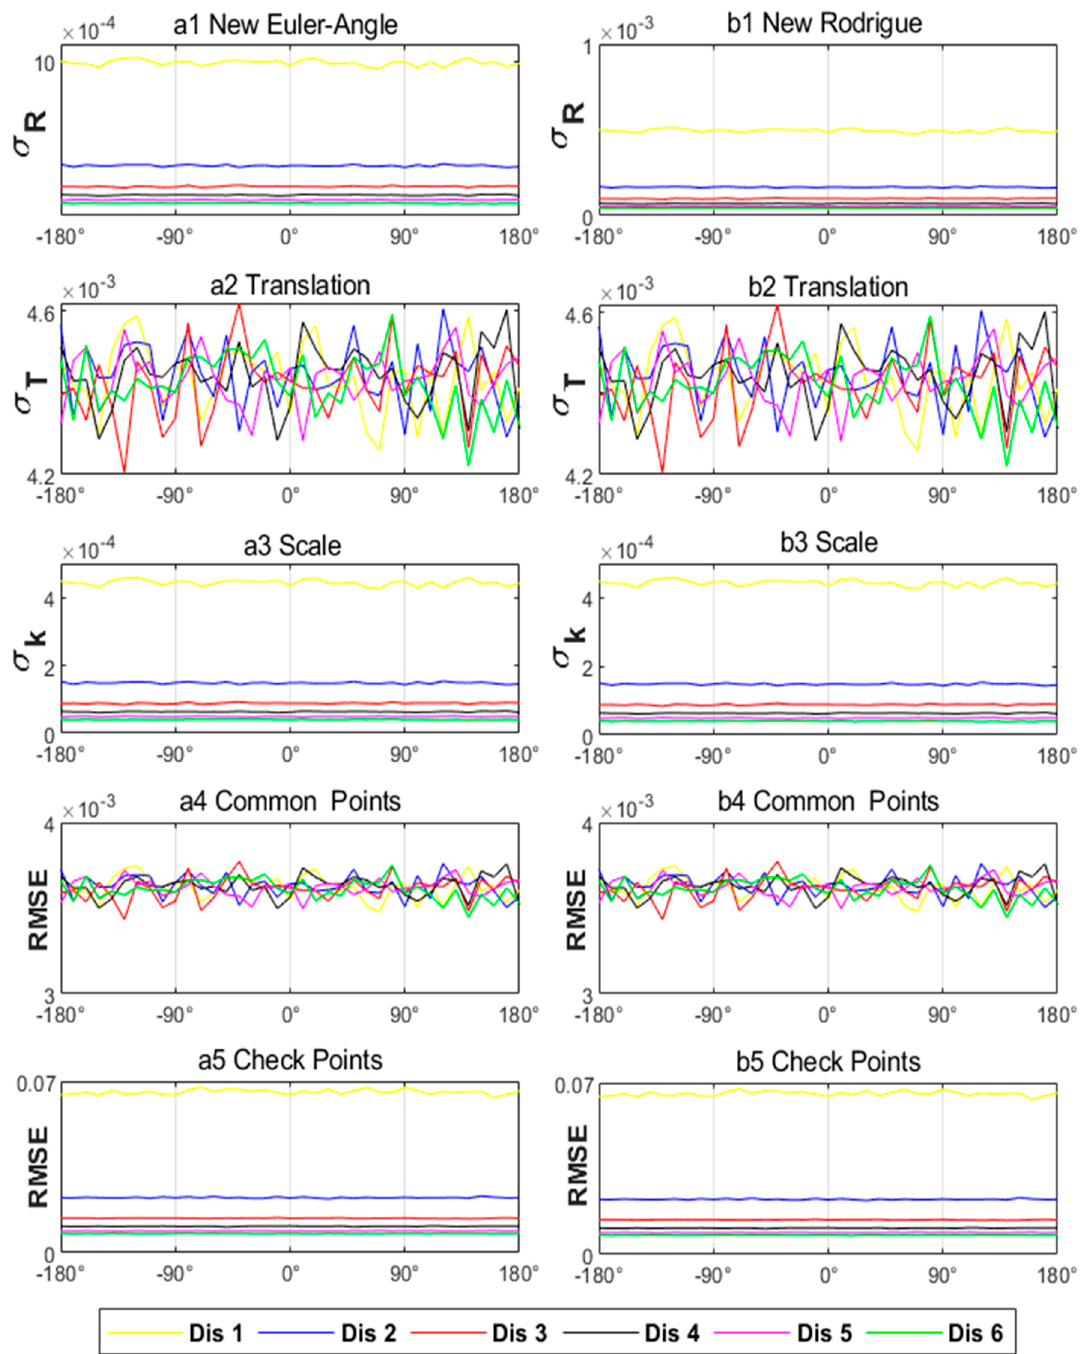
Figure 4. Transformation precision of the new transformation model for experiment II (each x axis value represents a different rotation angle, each y axis value represents a different precision for a different precision index ( a1 )- σ R (rad), ( b1 )- σ R (a.u.), σ T (m), σ k (a.u.), RMSE(m)), each color represents a different common points’ distribution, ( a1 – a5 ) shows the results of the proposed NEA-Method, ( b1 – b5 ) shows the results of the proposed NR-Method).